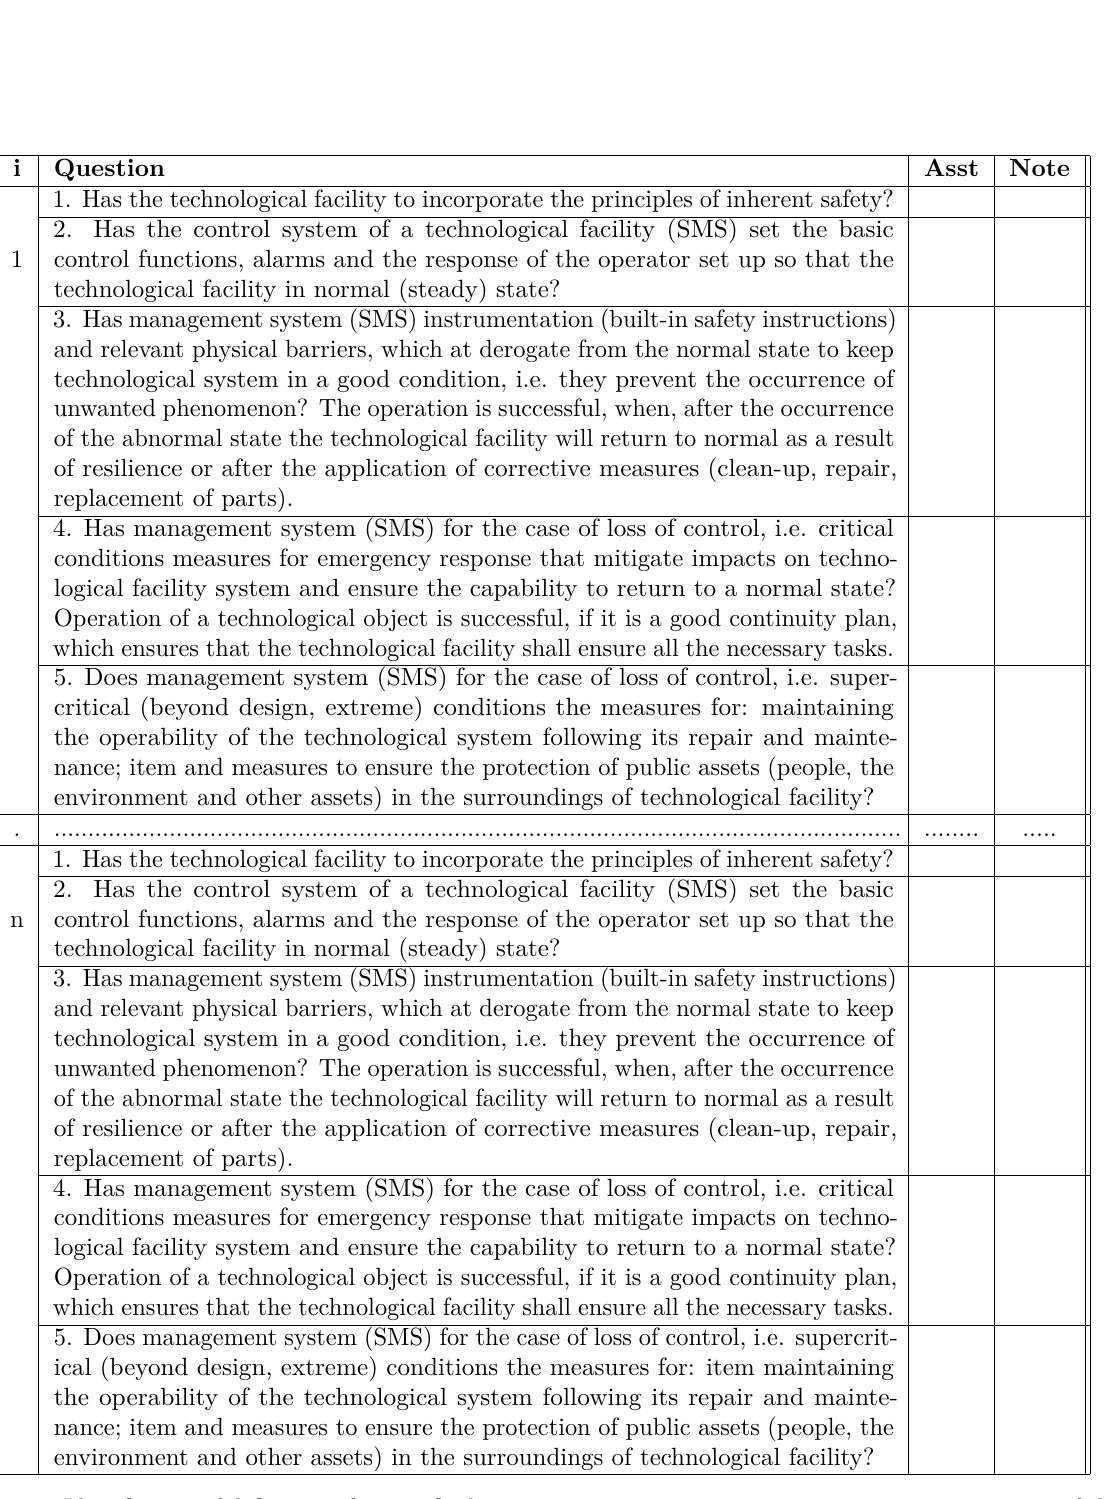
Table 1. Identification of deficiencies for specific disasters in a given territory, i = 1, 2, ..., n, i.e. assessment of the criticality of the viewpoint of the application of access the